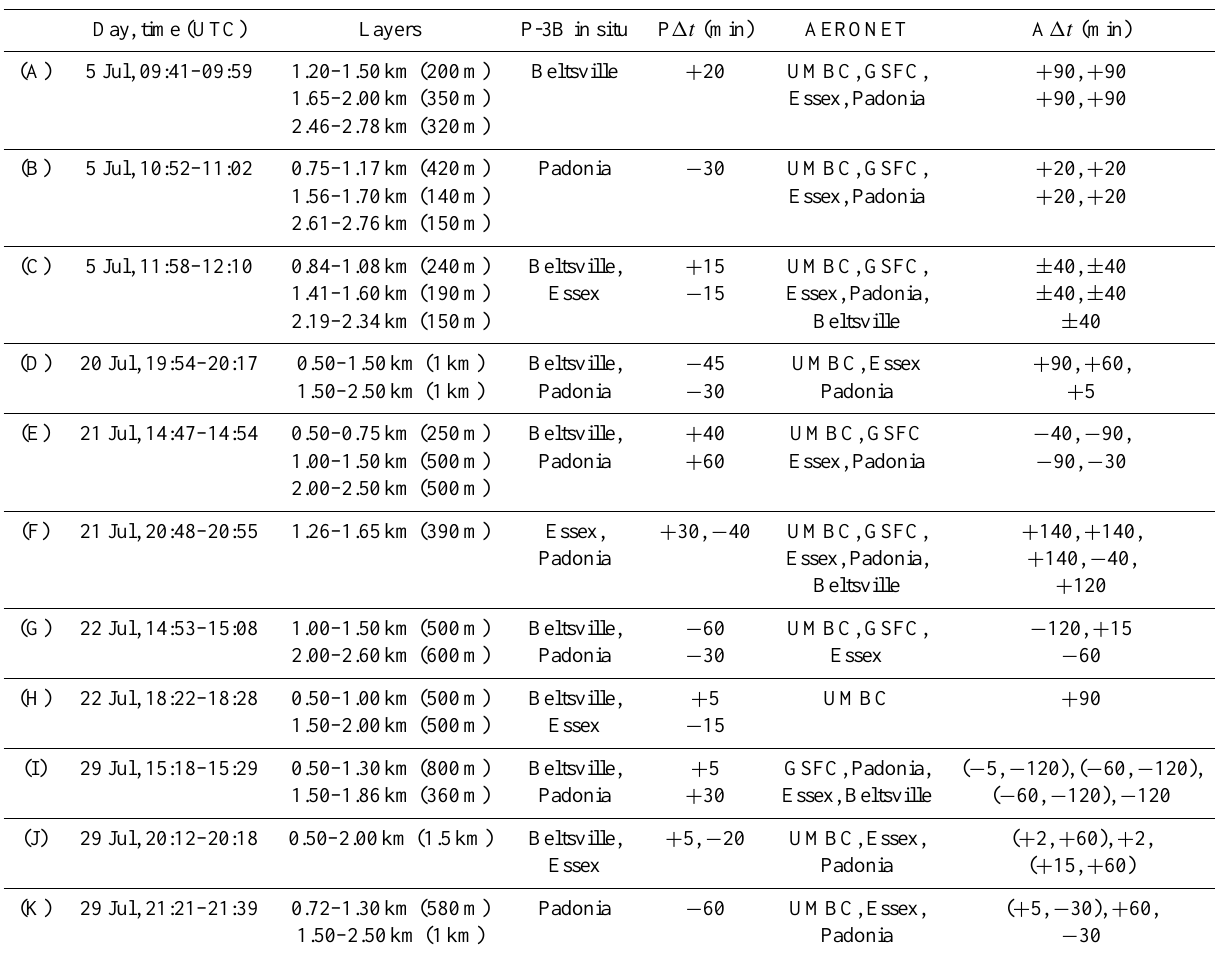
Table 1. List of cases analyzed. The letters in the first column represent the same cases as the ones depicted in Figs. 4 and 5. Time column lists the time span of the combined HSRL-1 and ALS-450 measurements. Layers were chosen in regions where the intensive properties such as color ratio and depolarization ratio did not vary much. P-3B in situ column lists the location of spirals which were used to compare lidar retrievals with in situ measurements, and P 1t lists the respective time gap between the overpass at UMBC and the spirals. The AERONET column lists the AERONET stations that were utilized for the retrievals comparison, including levels 1.5 and 2.0, and A 1t lists the respective time gap between the measurements at UMBC and the AERONET measurements. Figure 1 shows the AERONET and P-3B spirals’